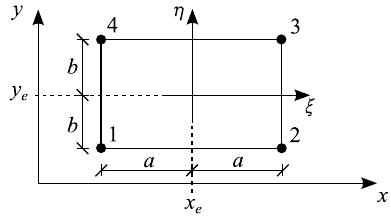
Figure 1. Four-noded rectangular plate element.